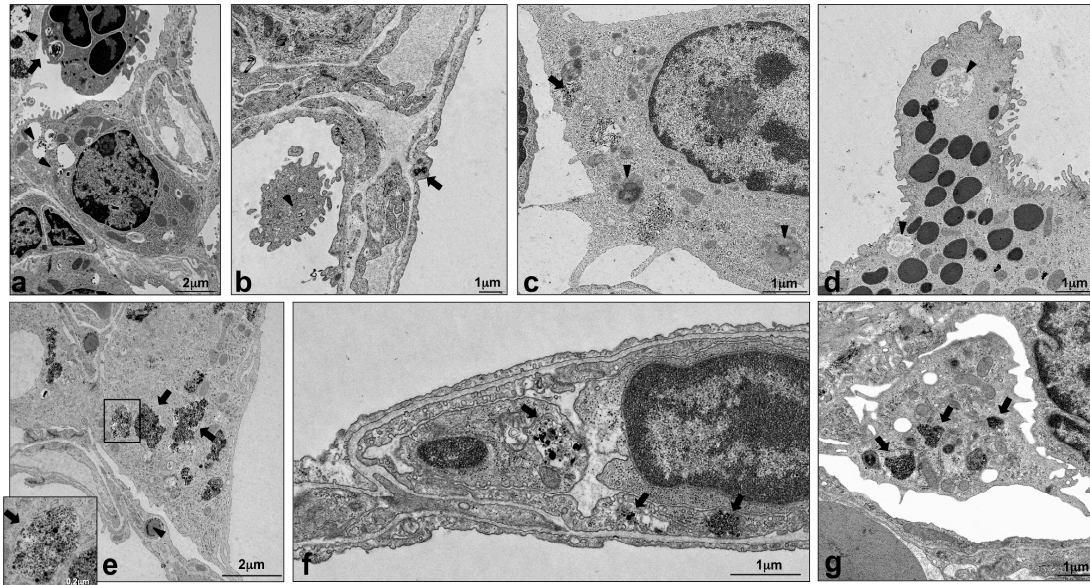
Figure 7 . Localization of SiO 2 NPs in the lungs by transmission electron microscopy. Representative pulmonary electron micrographs of NS ( a , b , f , g ) or S mice ( c , d , e ) exposed to SiO 2 plain ( a , b ), SiO 2 -PEG ( c , d ), SiO 2 -P ( e ), and SiO 2 -NH 2 ( f , g ). The analysis was performed 5 days after SiO 2 NPs instillation and OVA challenge. Ultrastructural localization of SiO 2 NPs (arrows) is evident in granulocytes ( a ), epithelial type I and type II cells ( a , b ), alveolar macrophages ( b , c , e , g ), endothelial cell ( f ). The particles were surrounded by a single membrane (arrow, inset in e ). Phagolysosomes and/or autophagosomes (arrowheads) are evident in alveolar macrophages ( b , c ) and Clara cells ( d ).